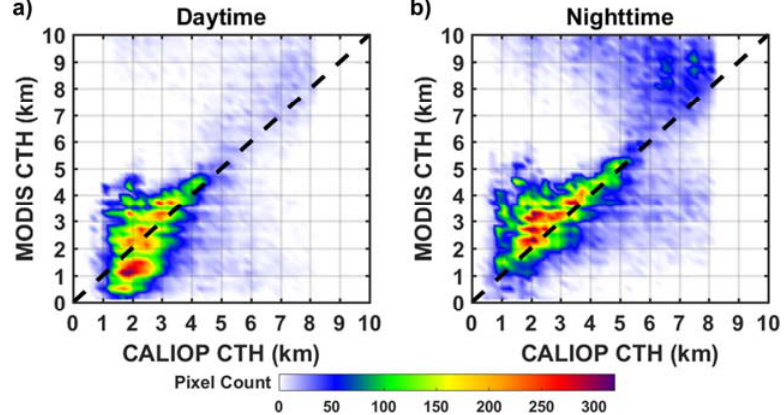
Figure 12. Density-colored scatterplots of MODIS cloud top heights (CTHs) at 1-km pixel and the collocated CALIOP CTHs for daytime ( a) , single-layer clouds only and nighttime ( b ) observations. The dashed black line represents the 1:1 line.